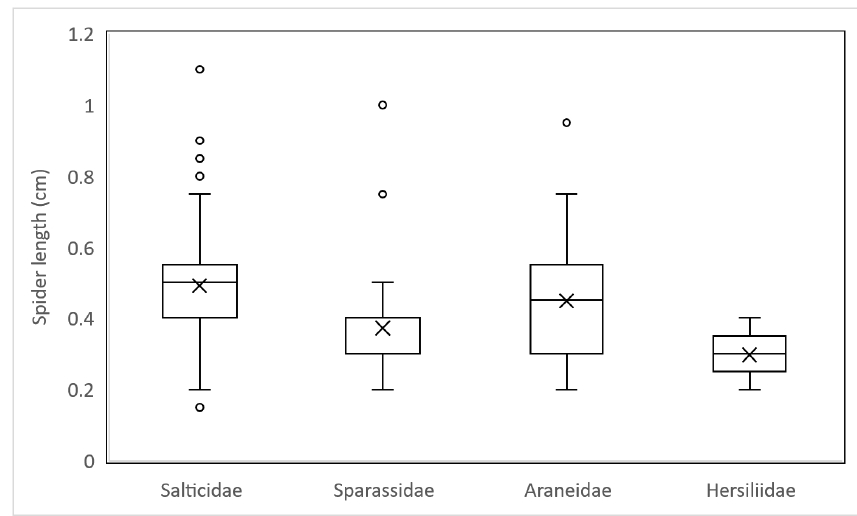
Figure 2. Spider body length for the four most abundant spider families found in mud nests of Sceliphron formosum (Hersiliidae, n = 29; Araneidae, n = 35, Sparassidae, n = 23; Salticidae, n = 515). Points of hollow represents outliers.